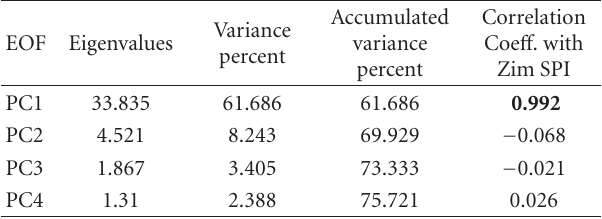
Table 1: Eigenvalues, percentages of the total variance explained by EOF 1 to 4, the corresponding percentage of the accumulated variance, and the correlation values between the PC amplitudes and Zim SPI. Significant values above 95% confidence level are indicated in